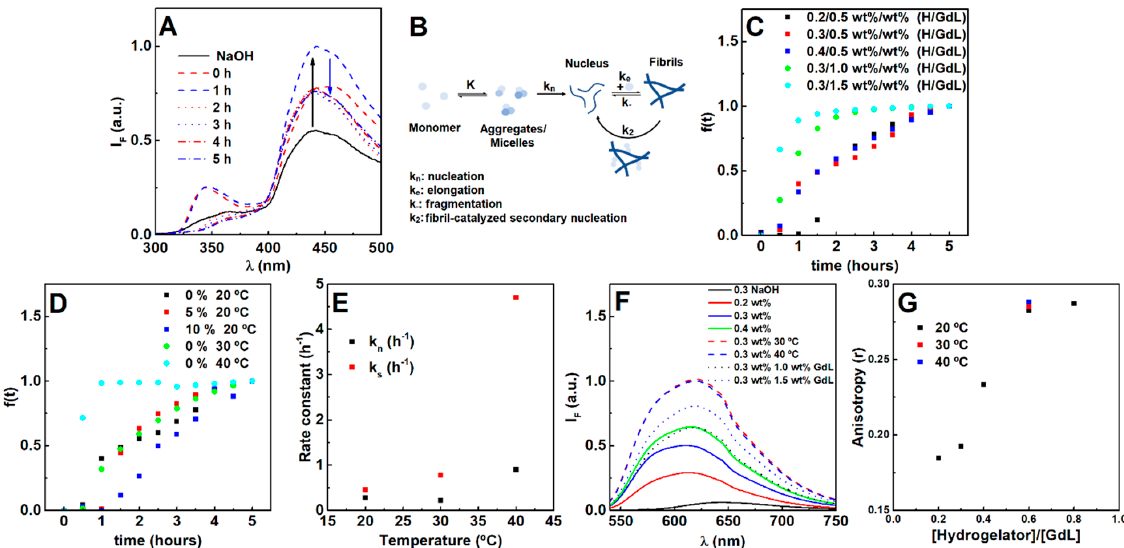
Figure 1. ( A ) Fluorescence emission spectra of the hydrogelator (0.3 wt%) over time after the gelation trigger (0.5 wt%). ( B ) Scheme of the evaluated pathways during the gelation process, where the fibril-catalyzed secondary nucleation contribution was found to be negligible. ( C ) Gelation kinetic profile dependence on hydrogelator and GdL concentration, ( D ) fibril concentration and temperature. ( E ) Average nucleation and elongation rate constants obtained from the Sait ô ’s aggregation model fitting to turbidity profiles at increasing temperatures (hydrogel 0.3 wt%, GdL 0.5 wt%). Fluorescence emission ( F ) and anisotropy r ( G ) of Nile Red (2 µ M) in hydrogels prepared at different hydrogelator-to-GdL ratios and temperatures (fixed hydrogel and GdL